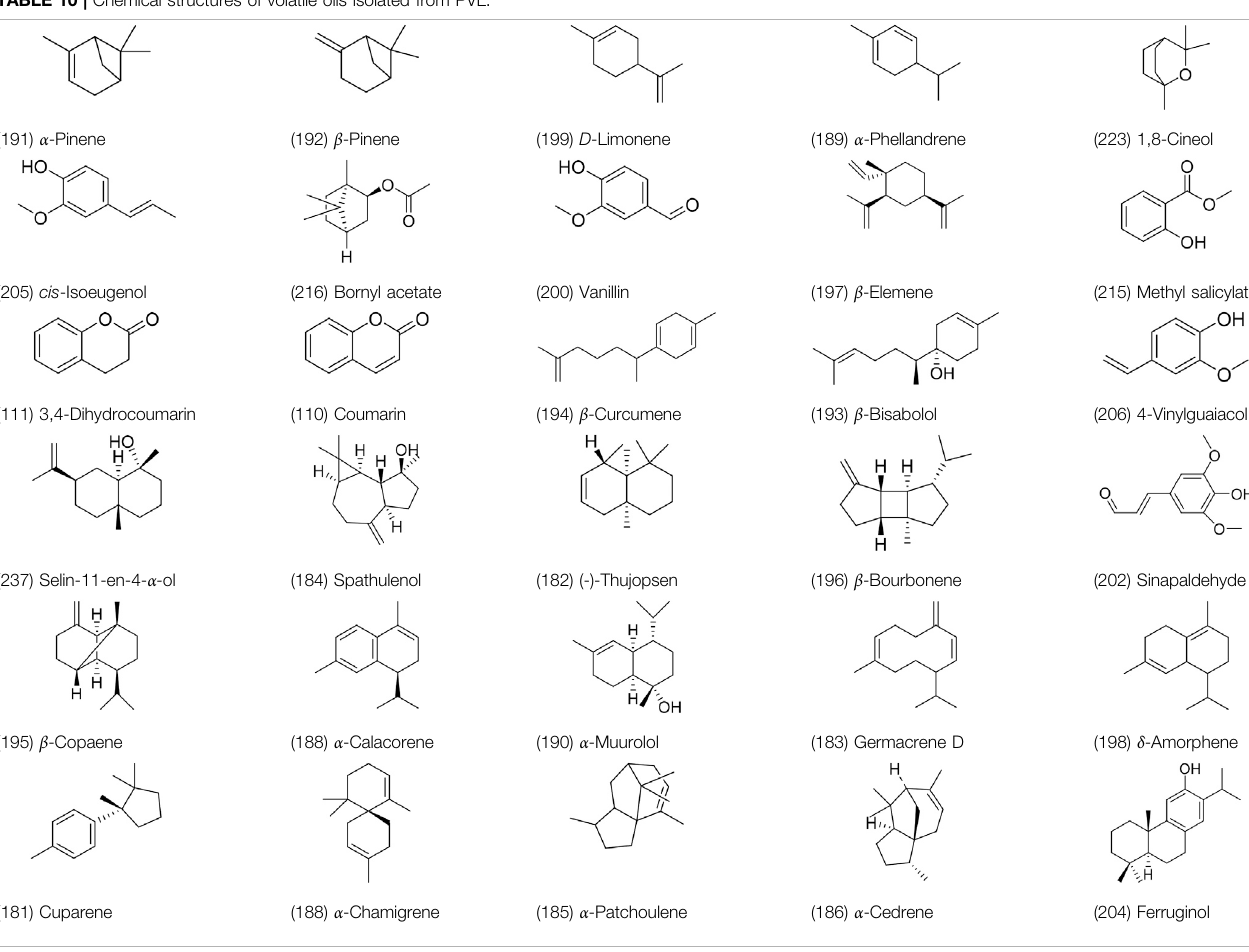
TABLE 10 | Chemical structures of volatile oils isolated from